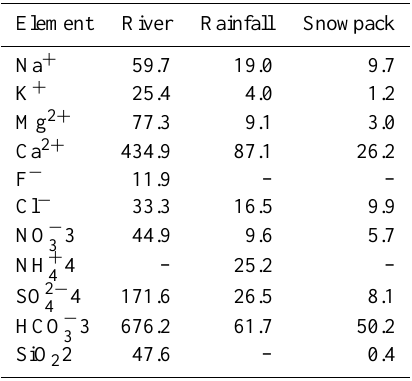
Table 1. Average solute concentrations (in µmoll − 1 ) measured in the Urumqi River (this study), in the snowpack (Williams et al., 1995) and in the precipitation (Zhao et al., 2008). Averages are volume-weighted for both precipitation and river